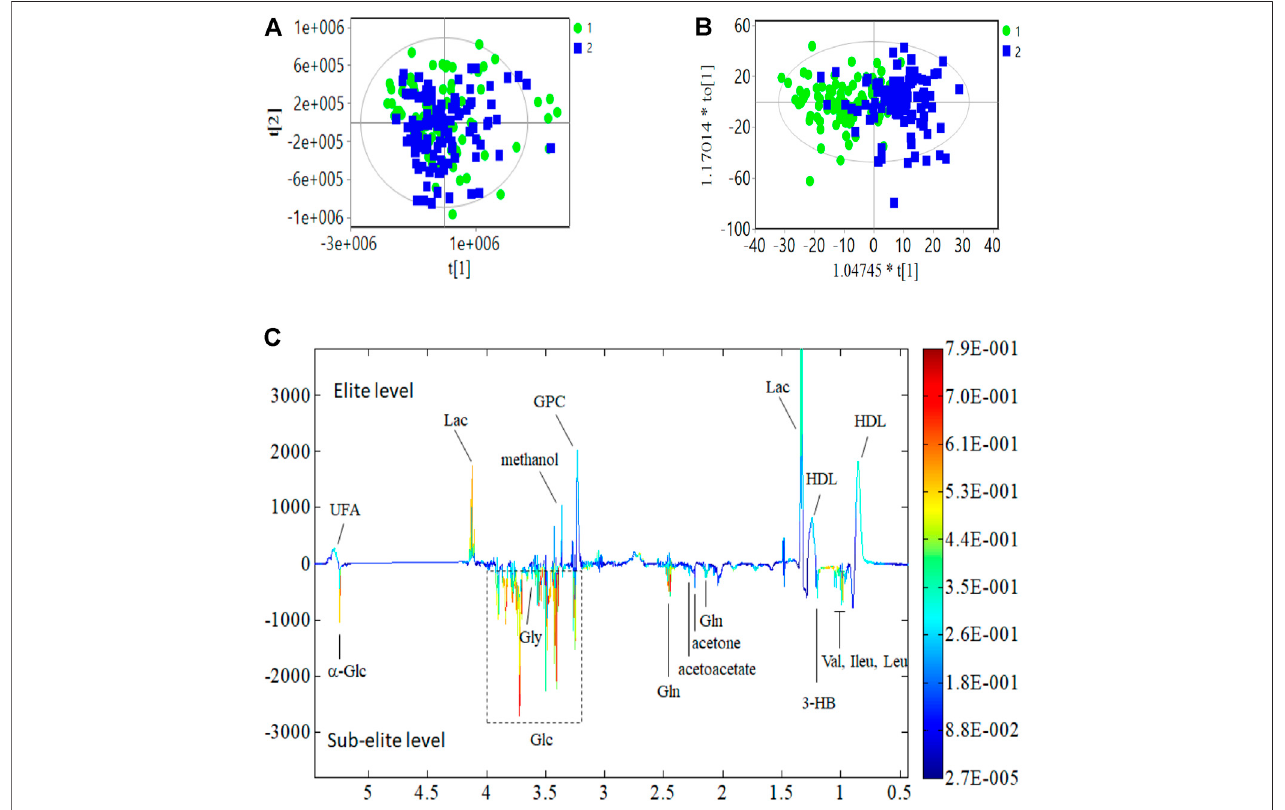
FIGURE1| PCA,O-PLS-DAanalysisandcoef fi cientofmetabolites. (A) PCAanalysis. (B) O-PLS-DAscoreplot; R 2 =0.551,Q 2 =0.417( p < 0.001); (C) Multicolor loading graph of multivariate metabolites analysis. 1: sub-elite level swimmers, 2: elite level swimmers